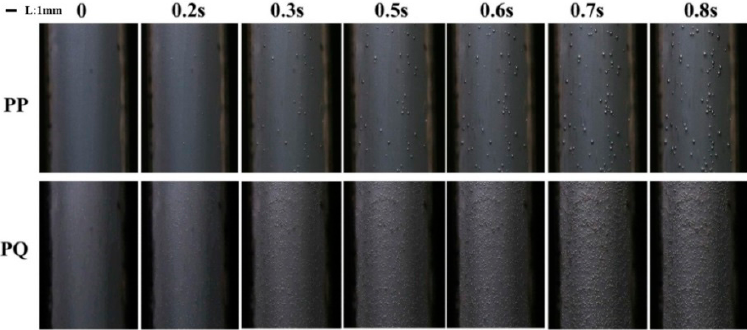
Figure 11. Pictures of the cells of the pure PP and the PQ composites changing over time.